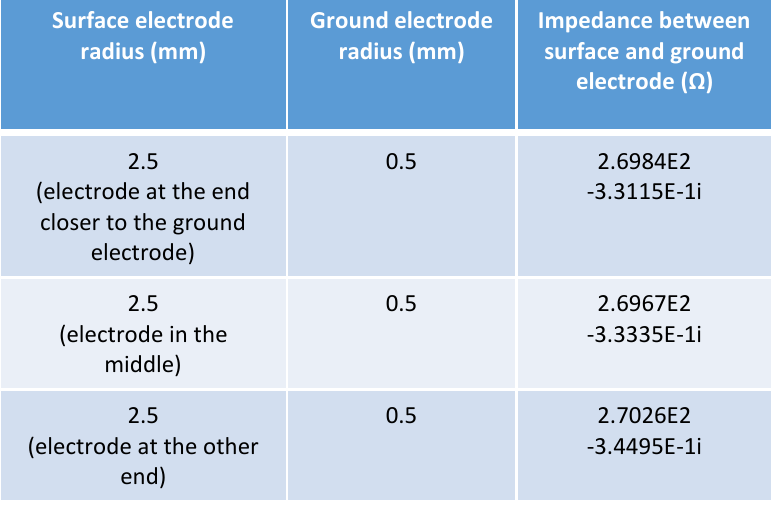
Table.2: Impedance measurements at 1 MHz with one of the 28 surface electrodes as terminal (7 electrodes in 4 rows) Surface